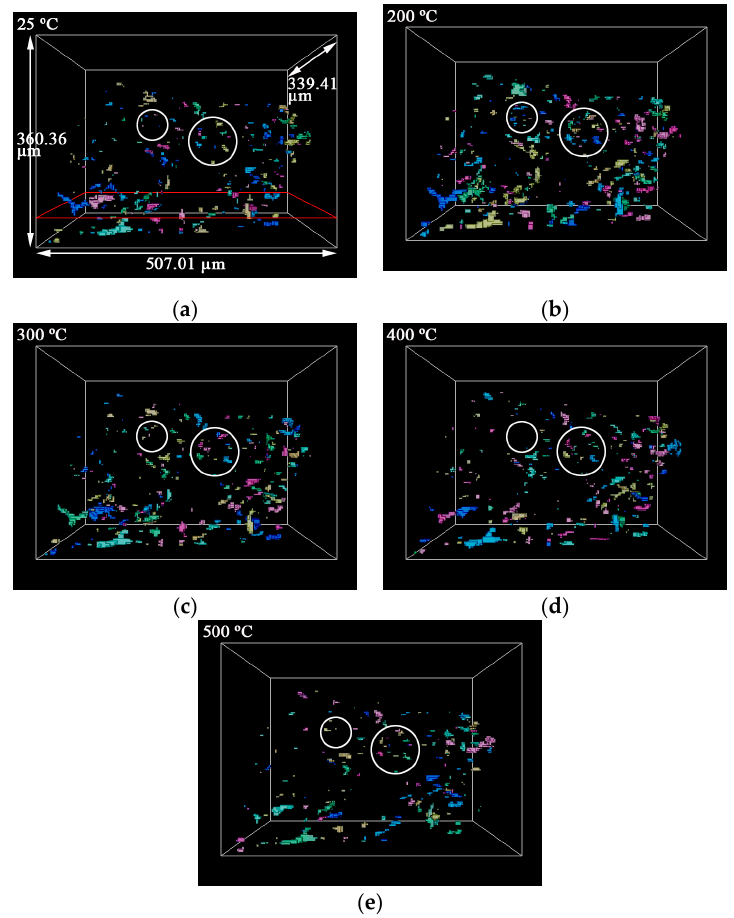
Figure 5. The 3D images of round-shaped (Type Ⅰ ) pores’ evolution with the temperature. ( a ) 25 °C. ( b ) 200 °C. ( c ) 300 °C. ( d ) 400 °C. ( e ) 500